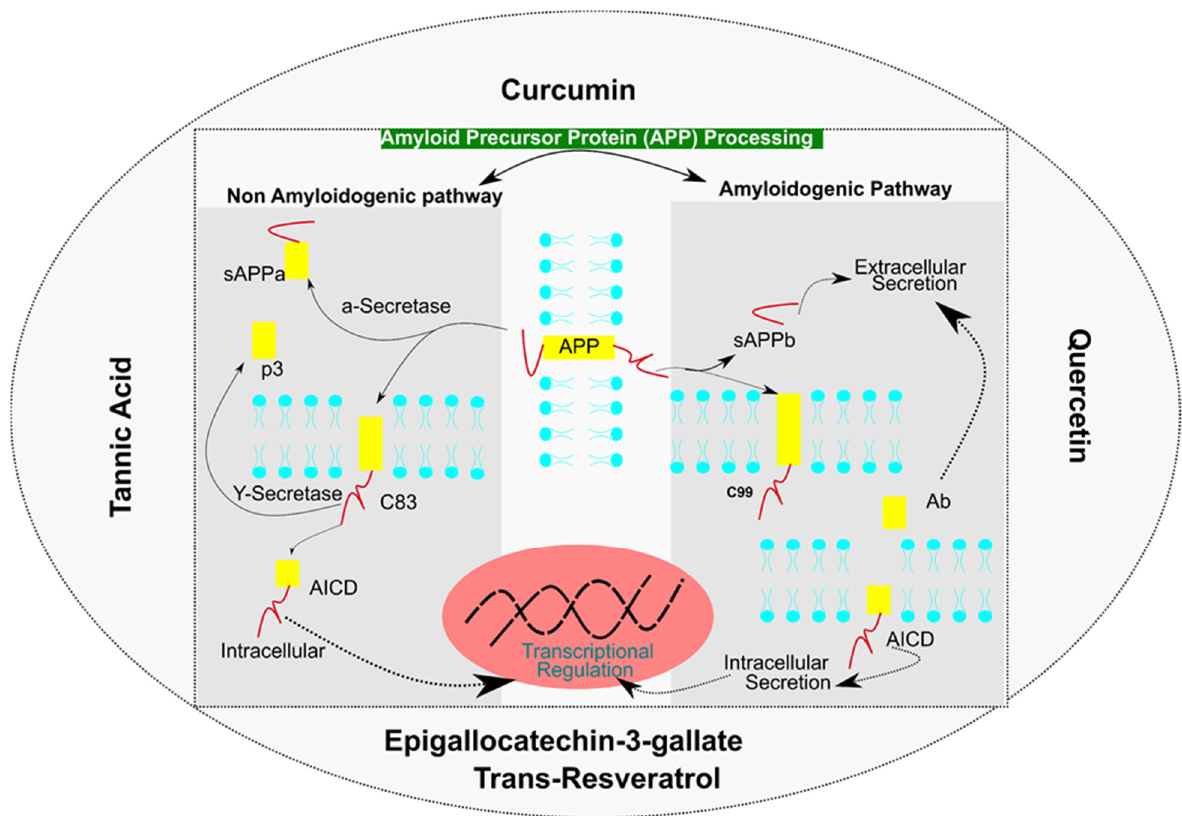
Figure 5. Dietary Polyphenols Influencing Amyloid Precursor Protein (APP) processing by modu- lating non-amyloidogenic pathway and amyloidogenic